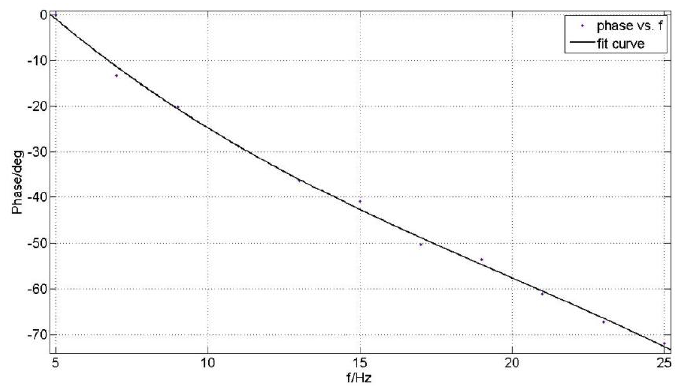
Figure 22. The experimental phase-frequency characteristic